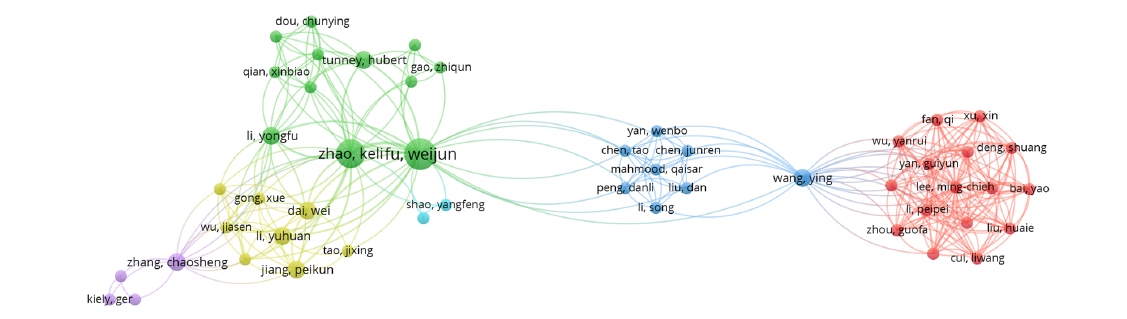
Fig. 2 . Co-authorship-author network for Dataset 1